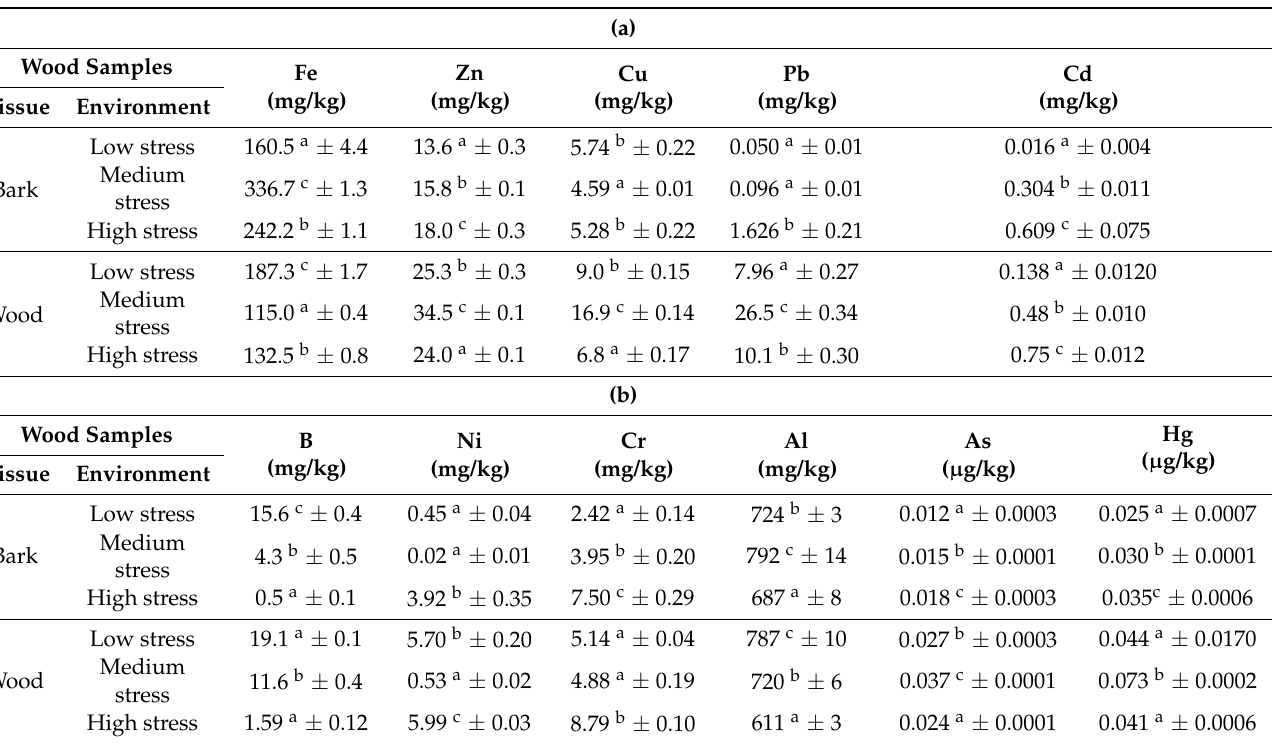
Table 3. ( a ) Chemical composition of elements (Fe, Zn, Cu, Pb, Cd) in Tilia cordata Mill. bark and wood; ( b ) Chemical composition of elements (B, Ni, Cr, Al, As, Hg) in Tilia cordata Mill. bark and wood.